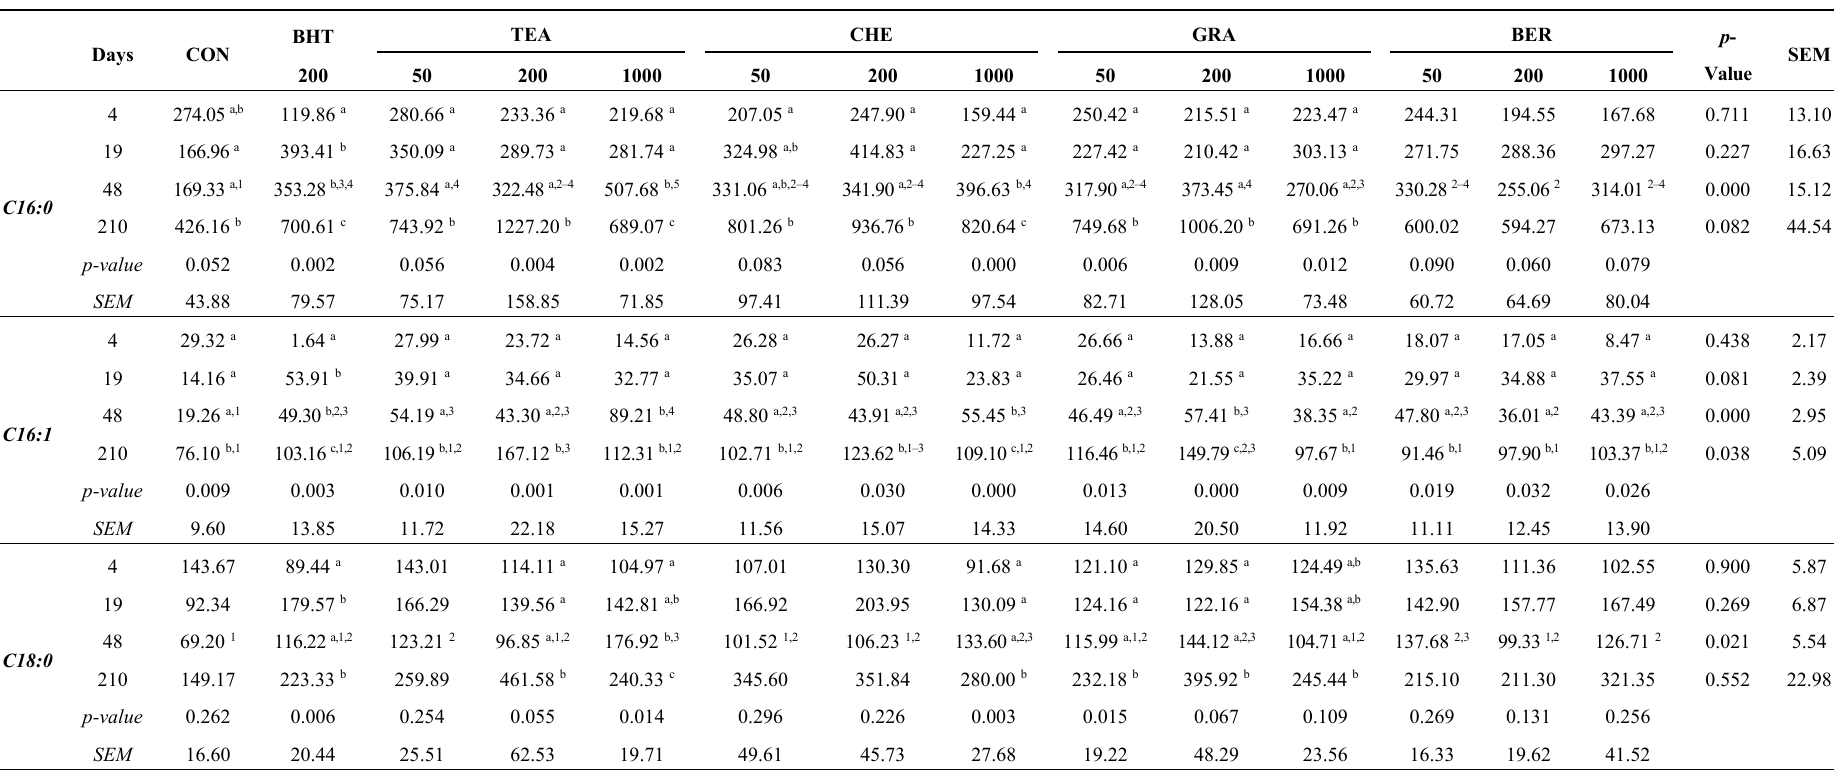
Table 4. Evolution of free fatty acid composition (mg/100g) of “chorizo” treated with BHT and natural antioxidants during ripening and